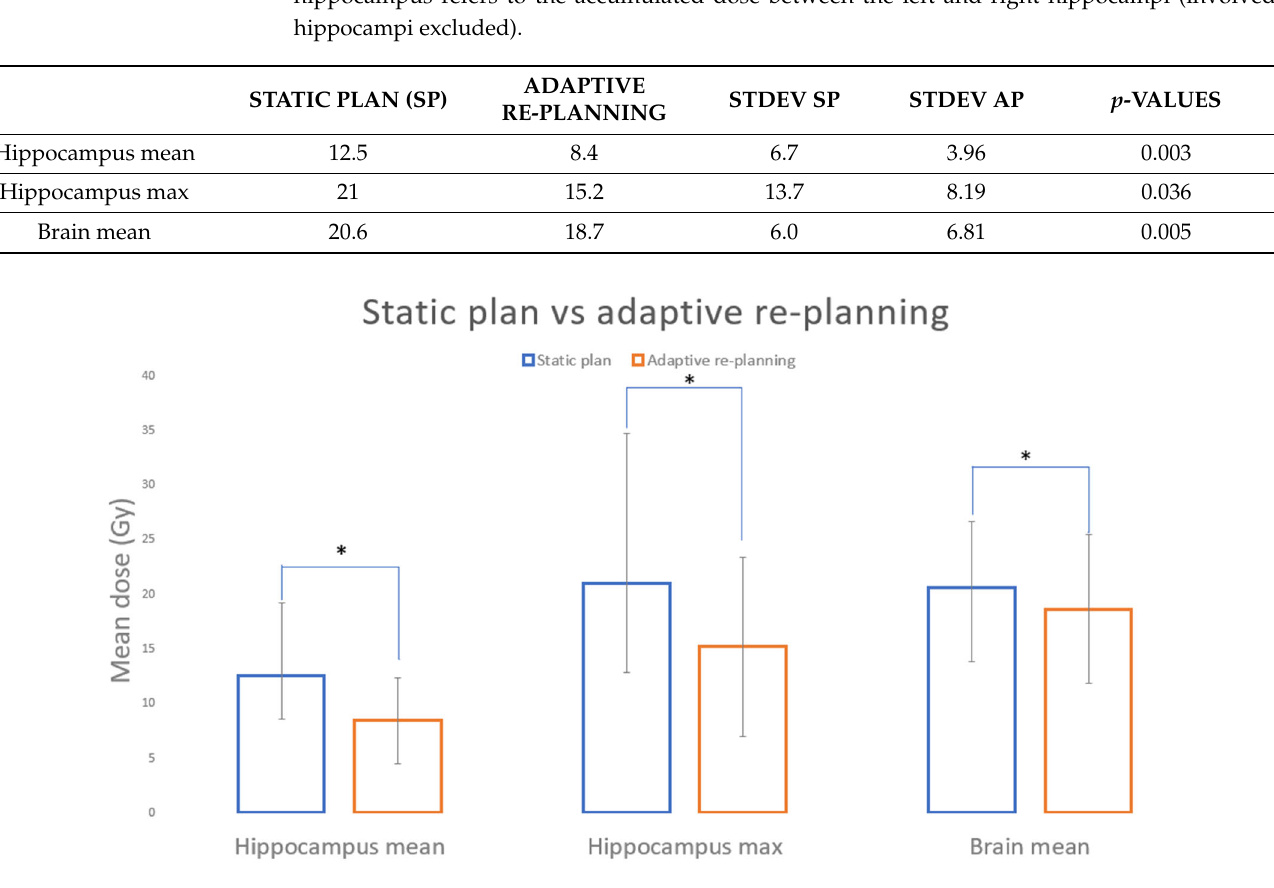
Figure 4. Static plan vs. adaptive re-planning (bars represent standard deviation). * Indicates statistical significance between the static and adaptive plans. Table 1. Static vs. adaptive plans for all patients. Mean and maximum (max) dose to hippocampus and brain. All numbers shown are in units of Gy.